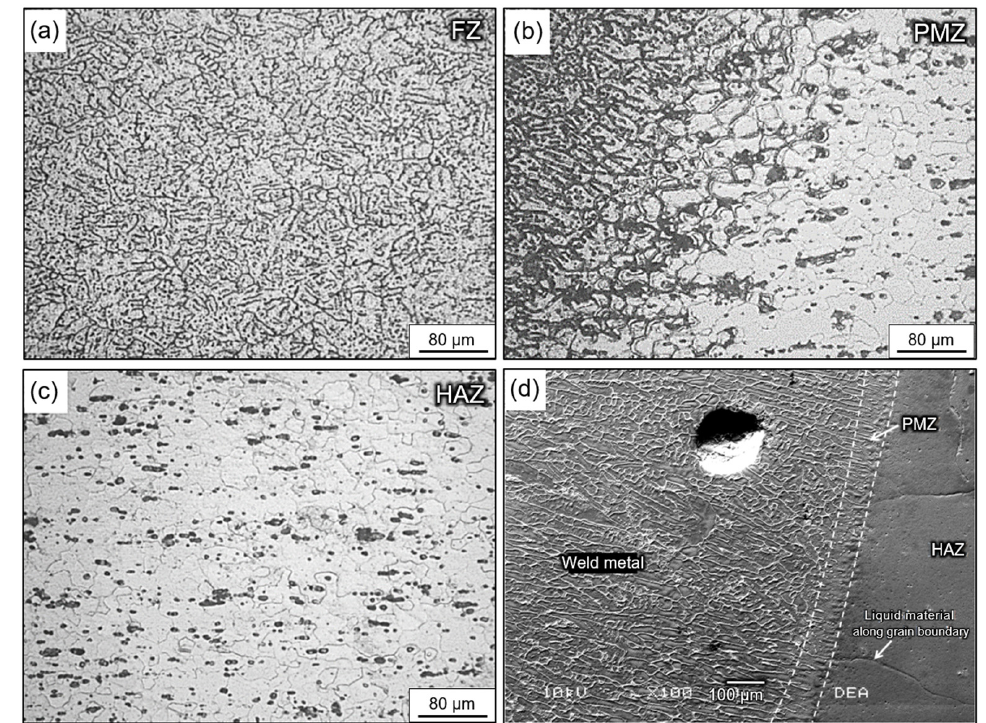
Figure 12. Typical weld microstructure of AA6061-T6: ( a ) equiaxed dendrites in fusion zone centre (FZ) [183]; ( b ) partially melted zone (PMZ) [183]; ( c ) heat-affected zone (HAZ) with precipitates (dark areas) [183]; and ( d ) scanning electron microscope image showing columnar dendritic grains growing epitaxially from base metal [184]. Subfigures were modified.